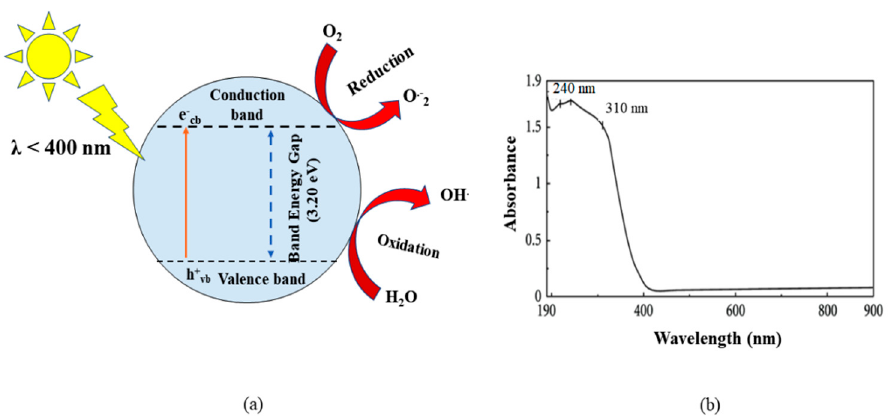
Figure 6. ( a ) Mechanism of generation of charged radicals from TiO 2 upon illumination within wavelength less than 400 nm; ( b ) UV-visible absorbance by TiO 2 particles within the wavelength range of 200–800 nm (reproduced from [77] Copyright 2012, International Journal of Photoenergy with permission under creative commons attributions 4.0 License).